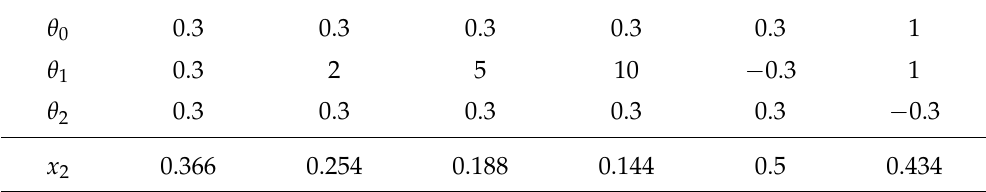
Table 2. Locally D-optimal designs { x 1 = 0, x 2 , x 3 = 1 } equally weighted obtained for the linear quadratic regression model when the probability distribution of the response is gamma. The nominal values of the parameters of the model are those considered in